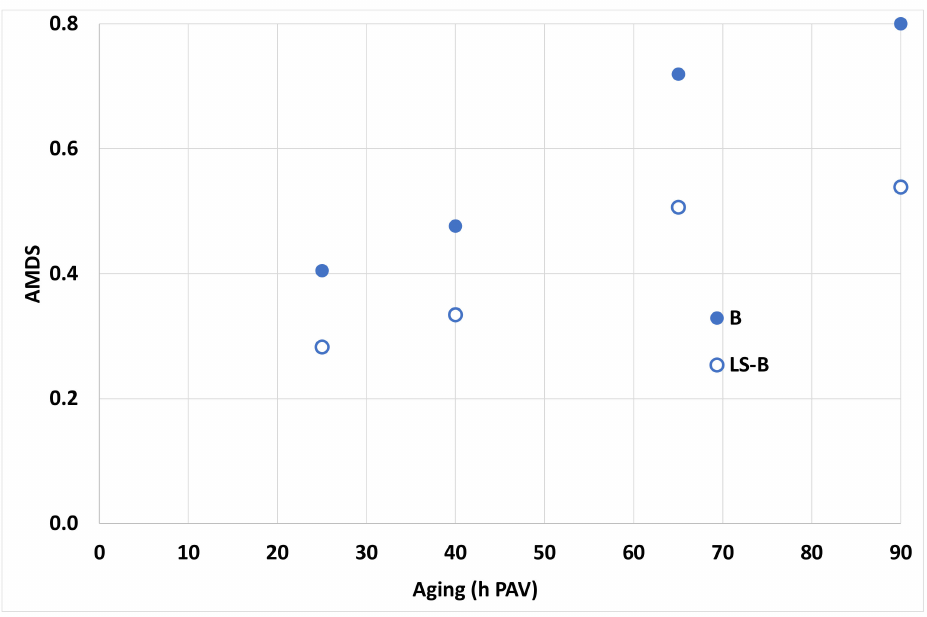
Figure 9. AMDS for the B and LS-B binders at different levels of